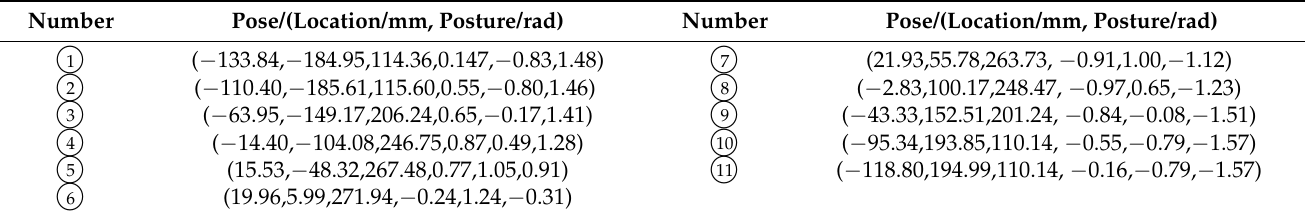
Table 1. The video inspection of the internal wall continuous path point sequence in the GIS cavity.